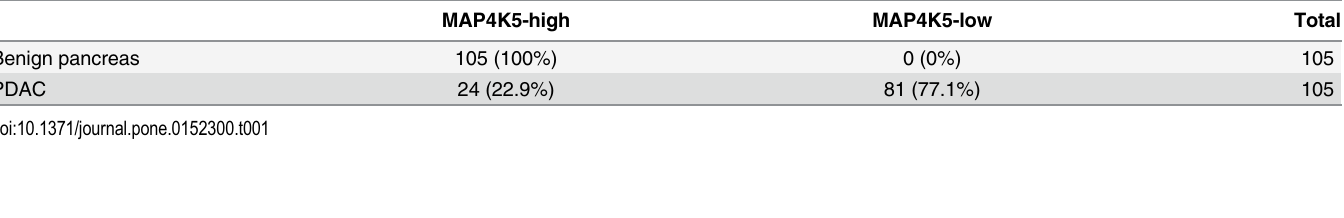
Table 1. Expression of MAP4K5 in pancreatic ductal adenocarcinoma and benign pancreas samples.